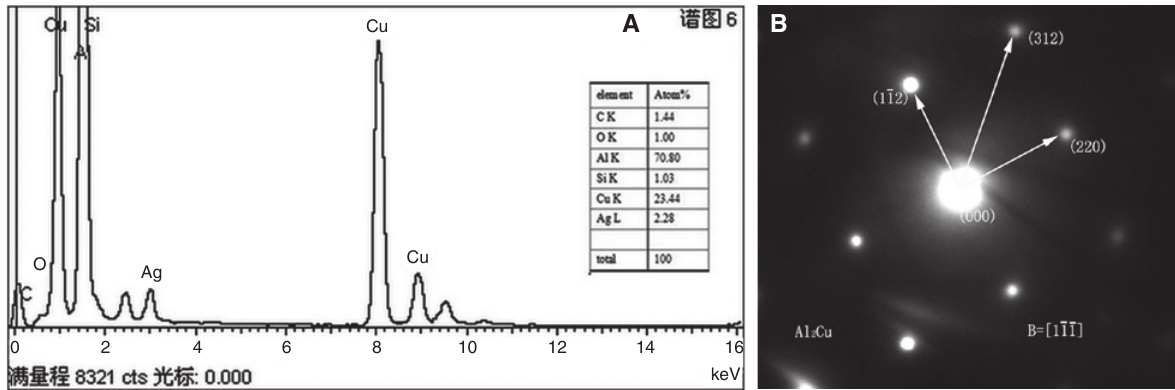
Figure 13 Spectrum obtained via EDAX in TEM and SADP of the spherical precipitates at the matrix of the composite (A) EDAX, (B) SADP.